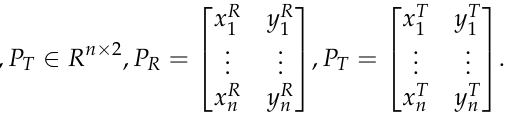
Figure 4. GUI of CPSP tool.